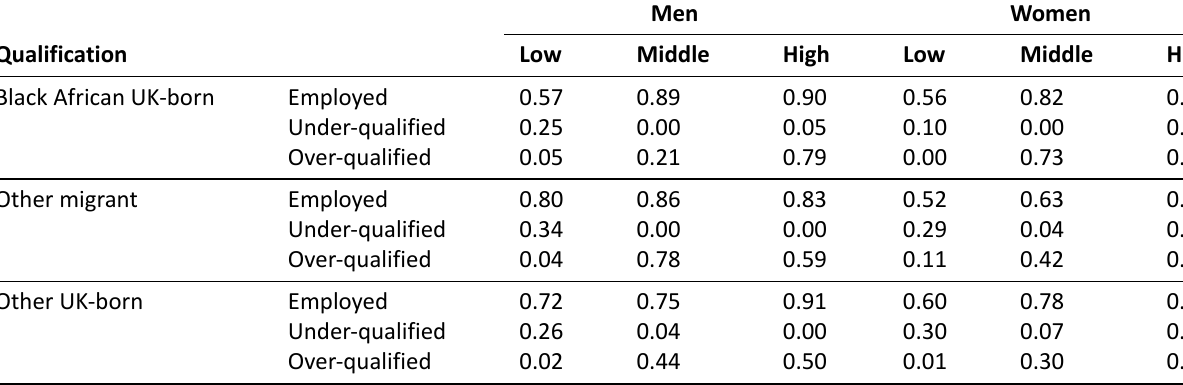
Table A2. (Cont.) Probability of employment and match with qualifications by qualifications and gender. Source: Under- standing Society 2009-2017, showing labour market outcomes by qualifications (low: at most upper secondary, middle: post-secondary non-tertiary, or high: tertiary) (Knies, 2017).